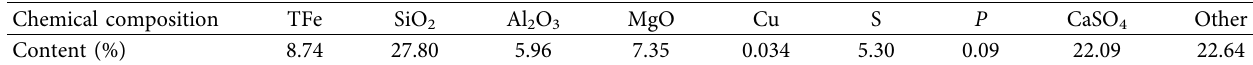
Figure 2: Particle size distribution of tailings. Table 2: Chemical composition of tailings.